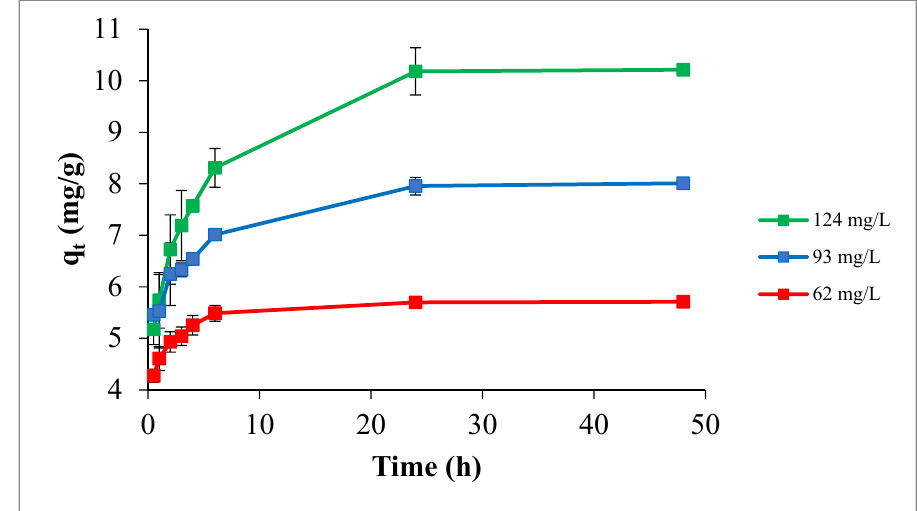
Figure 9. Influence of initial TPC concentration and contact time on adsorption process at temperature of 295 K, pH 5.0, adsorbent dose of 1% by weight.